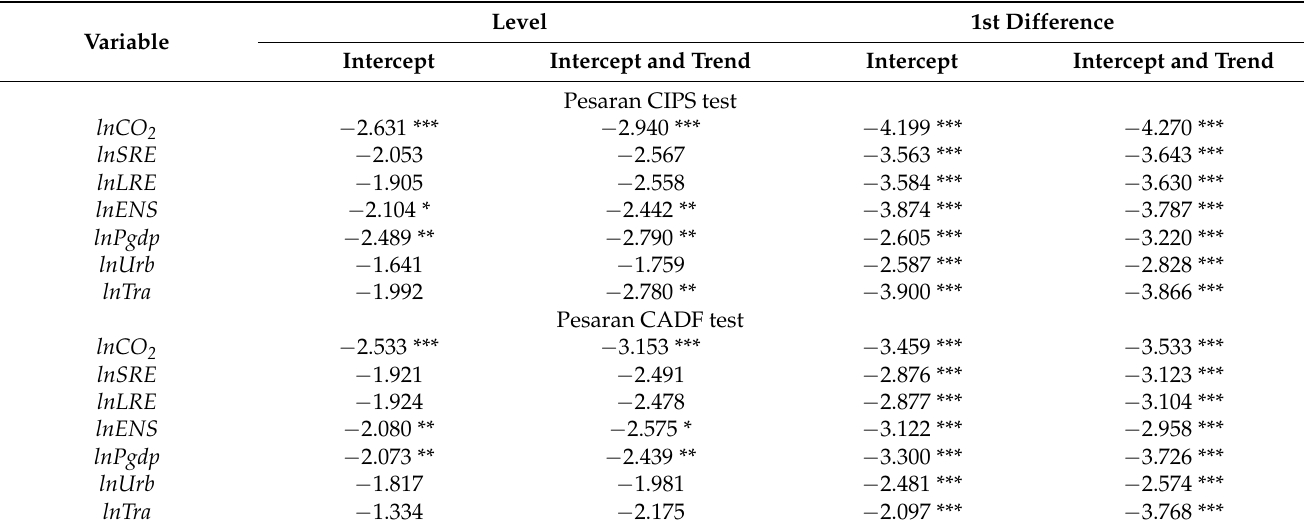
Table 4. Panel unit root test results.